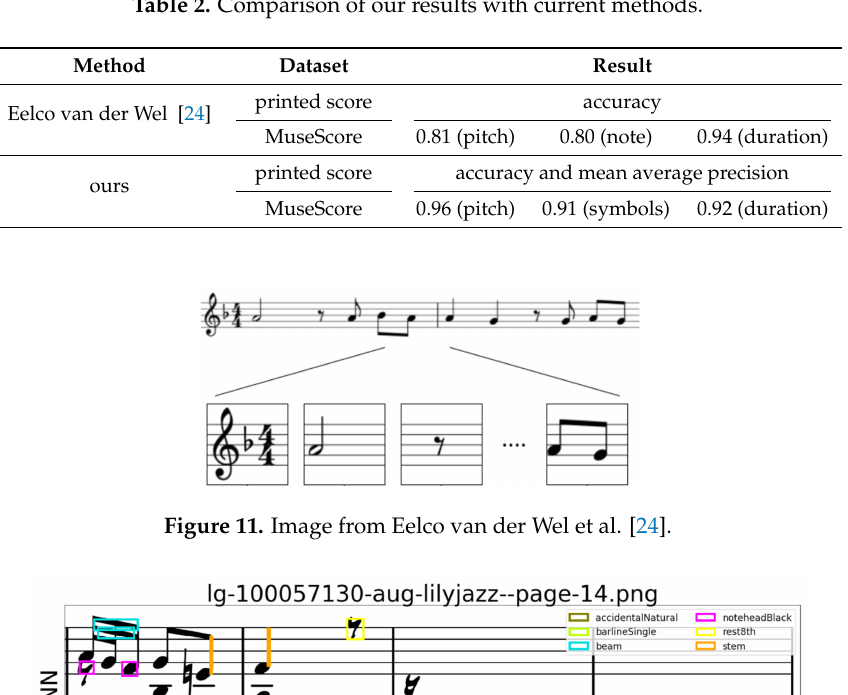
Table 2. Comparison of our results with current methods.